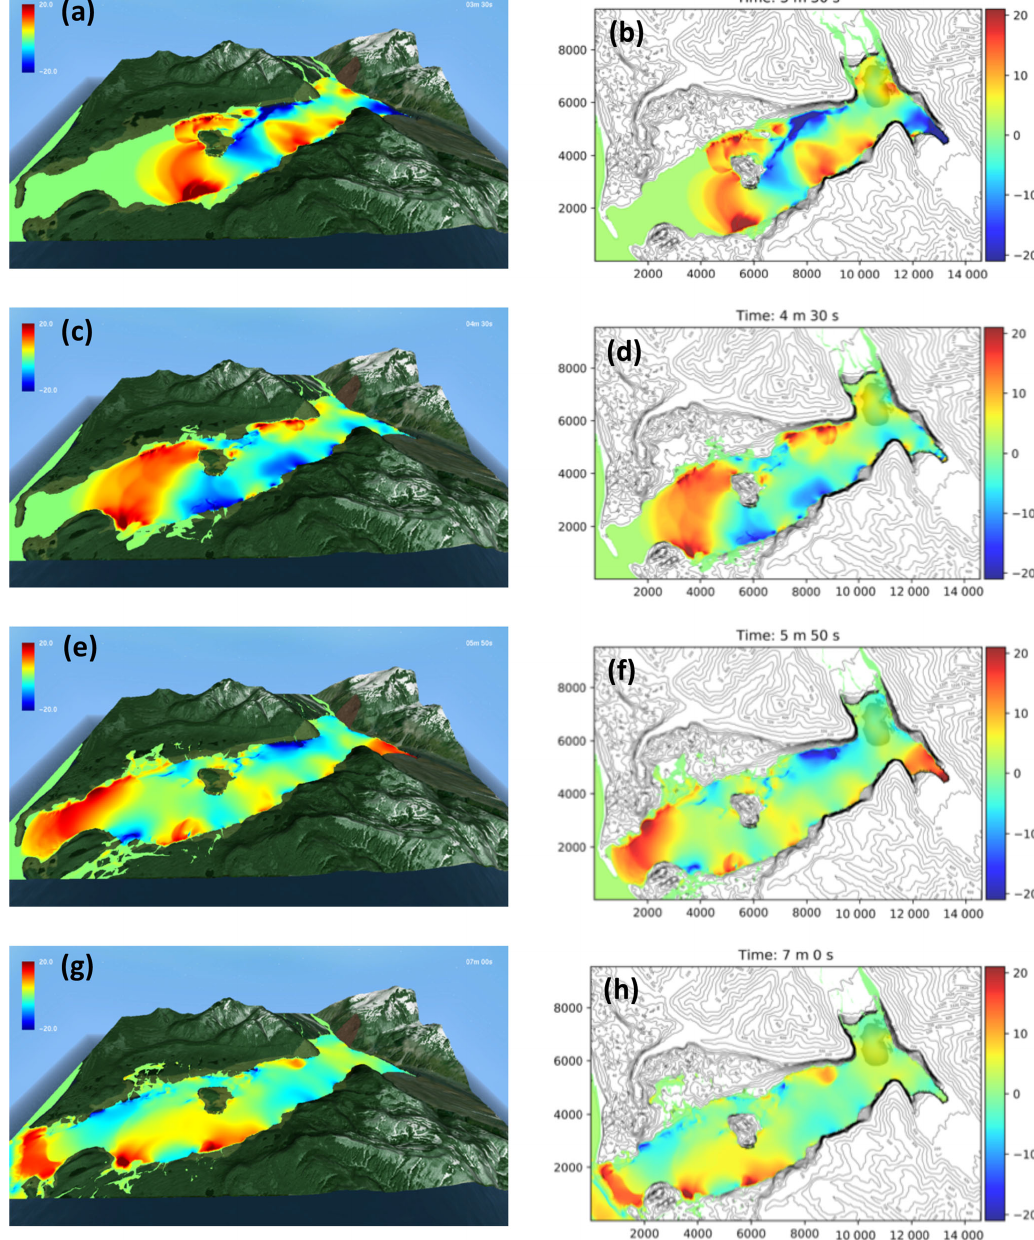
Figure 13. Wave evolution from t = 3min and 30s until t = 7min. In panels (b, d, f, h) the track of the inundated areas is kept. (a, c, e, g) South view; (b, d, f, h) plan